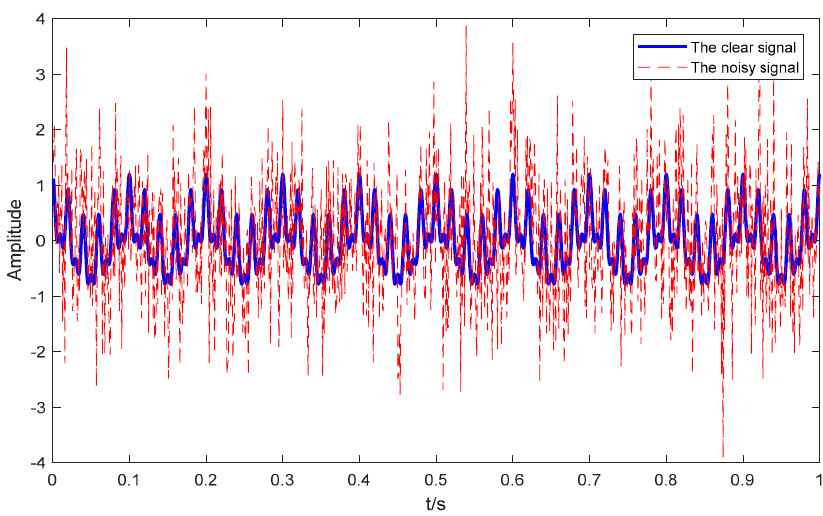
Figure 3. The time-domain waveforms of both the clear and noisy signals.